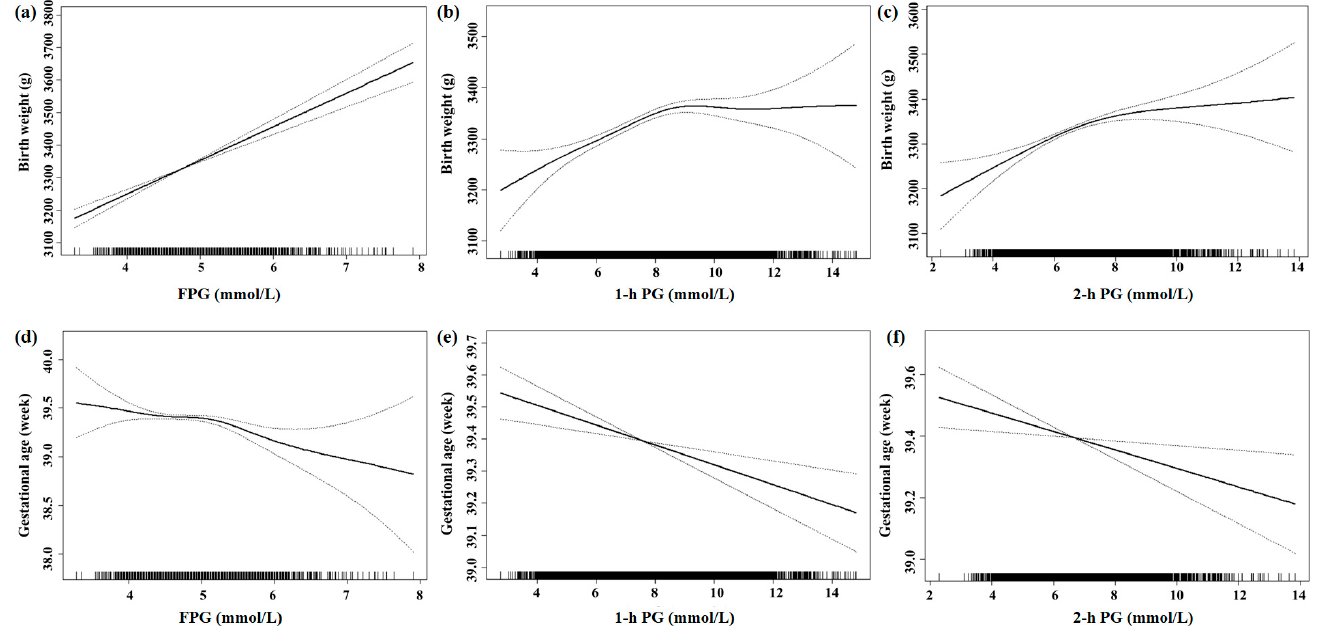
Figure 1. Association of blood glucose levels with birth weight and gestational age by smoothing spline. With the increase of FPG ( a ), the birth weight showed a linear upward trend. With the increase of 1-h PG ( b ) and 2-h PG ( c ), the birth weight showed a non-linear upward trend. With the increase of FPG ( d ), the gestational age showed a non-linear downward trend. With the increase of 1-h PG ( e ) and 2-h PG ( f ), the gestational age showed a linear downward trend.